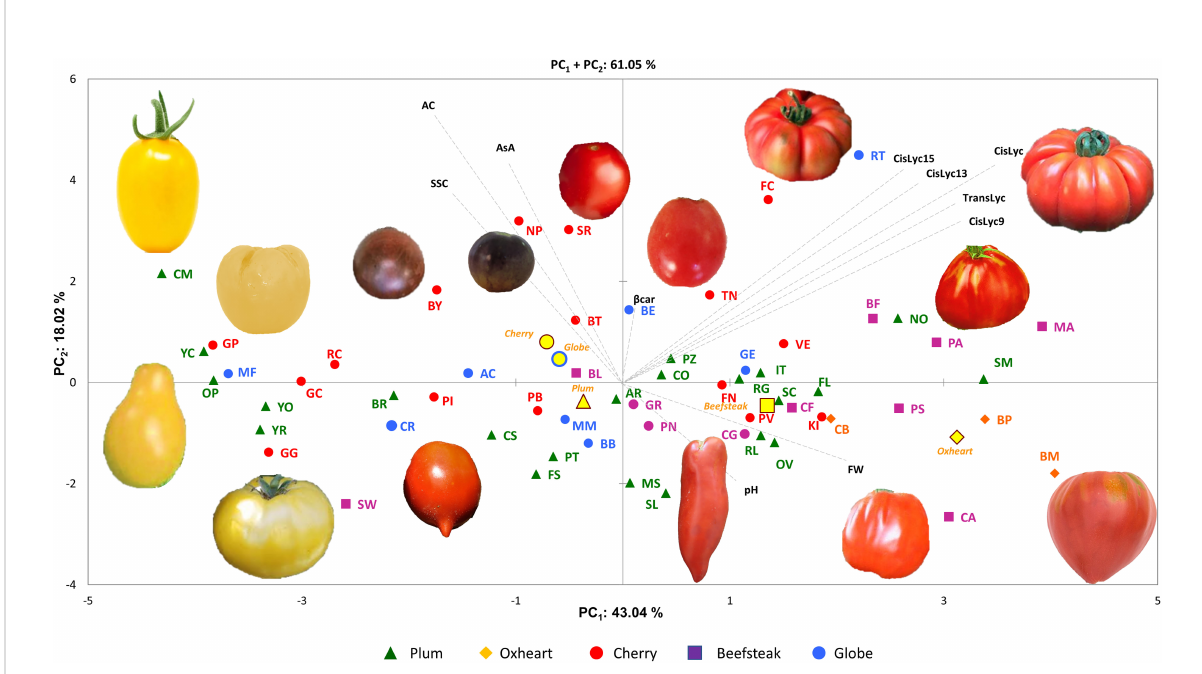
FIGURE 4 Principal component analysis. Loading plot of the fi rst (PC 1 ) and second (PC 2 ) principal components showing the variation for 10 traits scored across two seasons. Accessions of different cultivar groups are represented by different colored symbols. Examples of the morphological characteristics of the fruits for the studied accessions are included in the fi gure. Color and symbols are listed in the graph ’ s legend. The fi rst and second component centroids for each cultivar group are indicated by fi lled yellow symbols with shape and edge color according to cultivar groups (see legend). The direction and distance from the center of the biplot indicate how each trait scored contributes to the fi rst two components. Trait acronyms are listed in Table